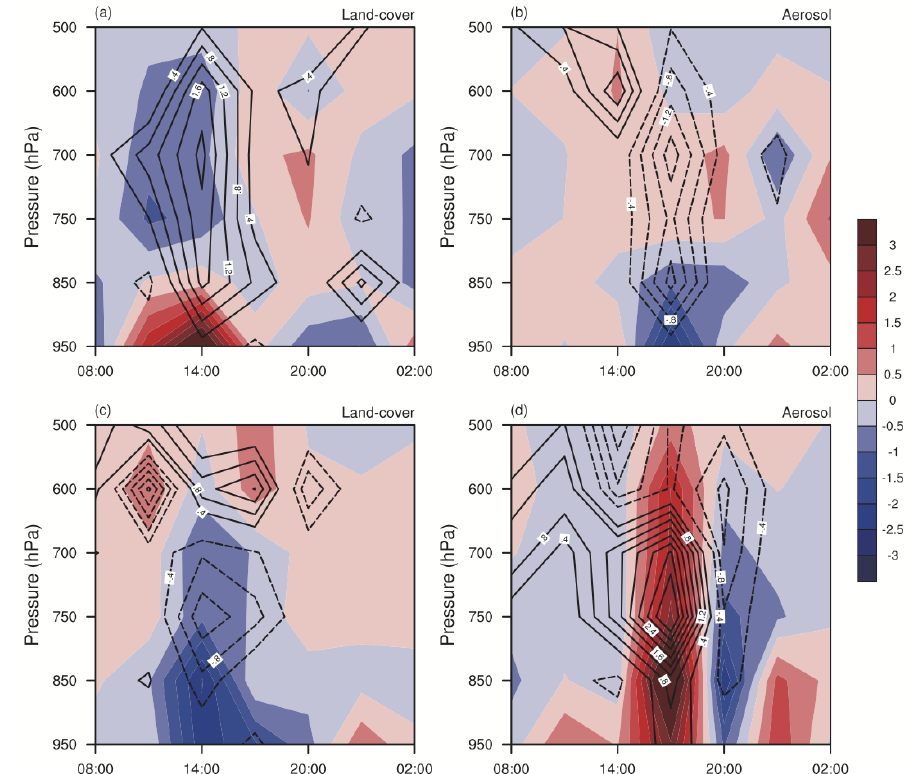
Figure 14. The time–height cross sections of differences in moisture flux convergence (shaded; units: 10 − 4 g − 1 kg − 1 s − 1 ) and water vapor mixing ratio (black lines; units: 10 − 2 gkg − 1 ) from 08:00 on 23 June 2006 to 02:00 on 24 June 2006 (LST) (case A) over region R1 (denoted in Fig. 12a) between (a) LU06E70 and LU70E70 and (b) LU70E06 and LU70E70. Panels (c, d) are the same as (a, b) but for case B from 08:00 on 1 July 2006 to 02:00 on 2 July 2006 (LST) over R2 (denoted Fig.